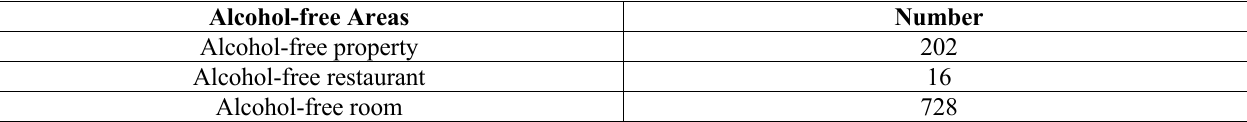
Table 3. Alcohol-free areas Source: Authors’ elaboration